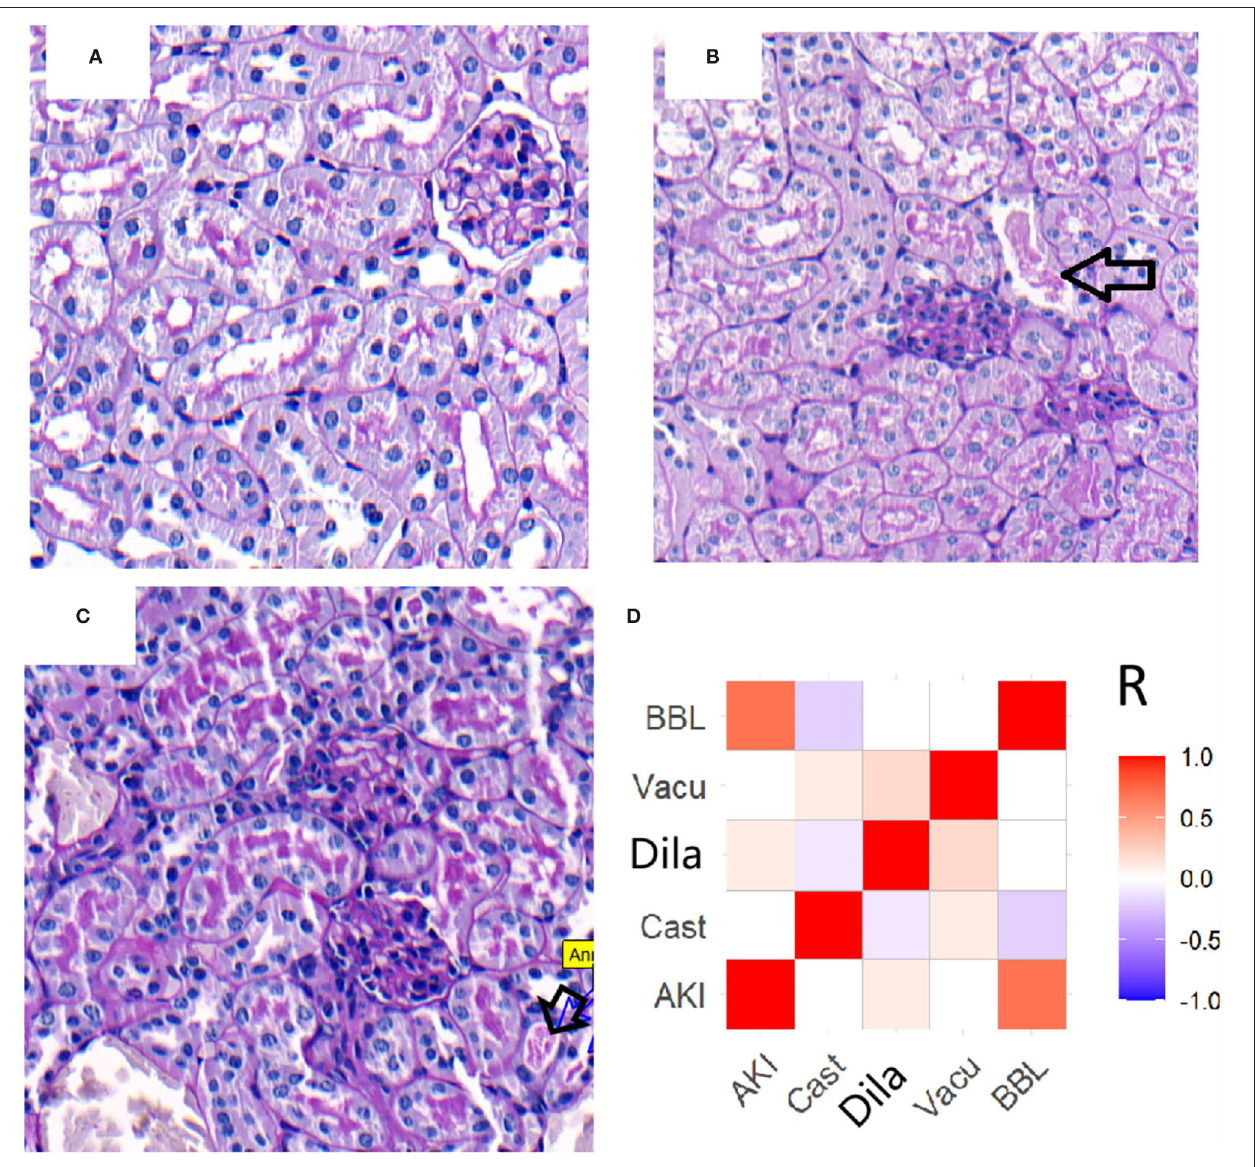
FIGURE 3 | Representative images (original magnification, × 200) of brush border loss in CLP AKI mice. (A) CLP48hAKI mice without BBL. (B) Focal BBL in renal cortical fields of CLP24hAKI mice. (C) Local BBL in renal cortical fields of CLP28hAKI mice. (D) Correlations between AKI and acute tubular lesions in patients. AKI correlated with BBL score significantly ( R = 0.752, p < 0.001). The completely loss of brush border (arrows). CLP24hAKI, AKI after CLP 24h; CLP48hAKI, AKI after CLP 48h.AKI, acute kidney injury; Cast, tubular cast formation; Dila, tubular dilation; Vacu, tubular vacuolation; BBL, brush border